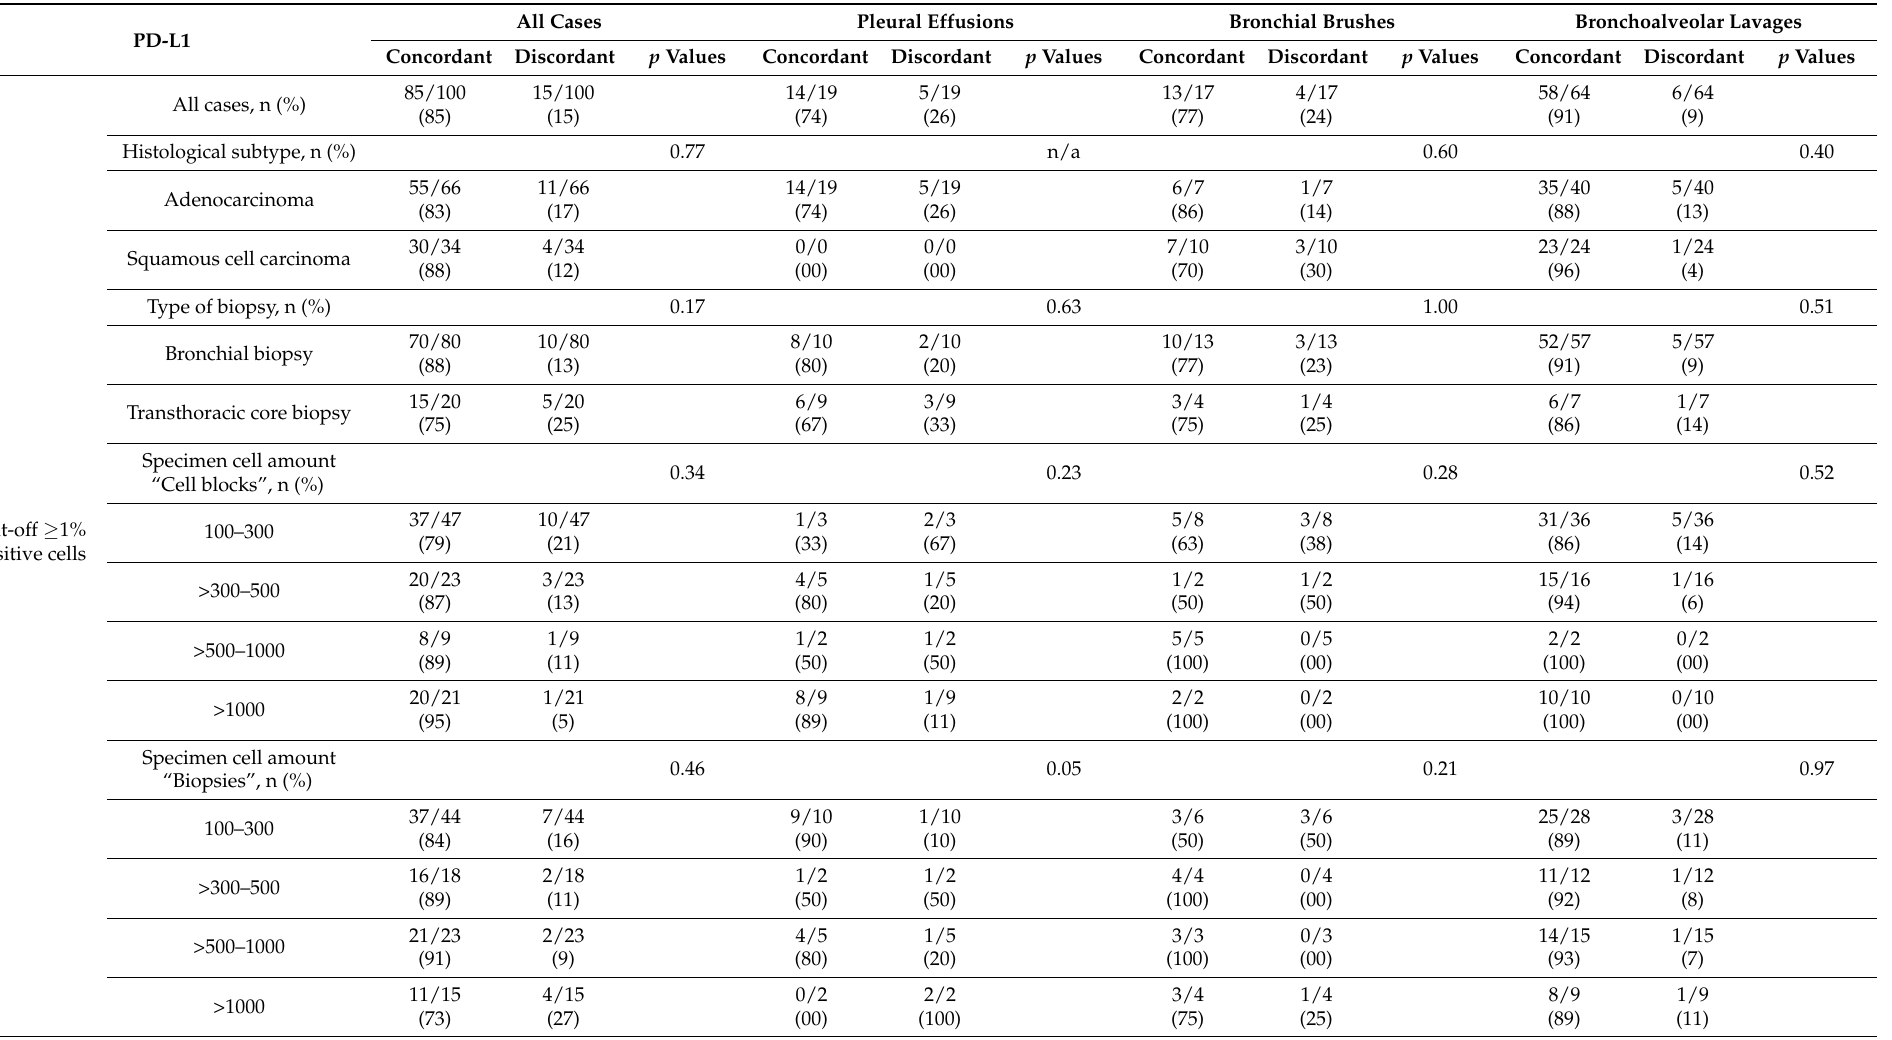
Table 3. Association of PD-L1 concordance for paired histological and cytological non-small cell lung cancer specimens with tumour type, specimen type, and cell content. All Cases Pleural Effusions Bronchial Brushes Bronchoalveolar Lavages PD-L1 Concordant Discordant p Values Concordant Discordant p Values Concordant Discordant p Values Concordant Discordant p Values All cases, n (%) Histological subtype, n (%)